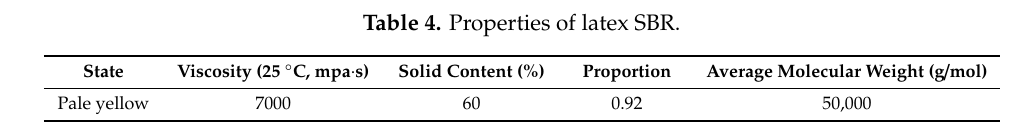
Table 4. Properties of latex SBR.